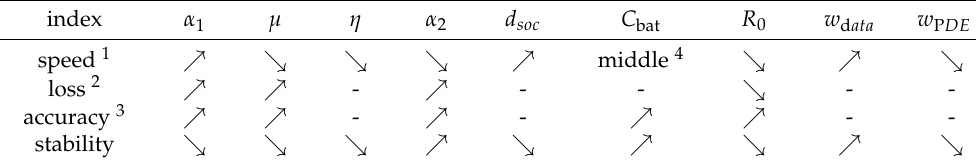
Table 7. Positive and negative correlation of the nine main fractional-order parameters to the algorithm